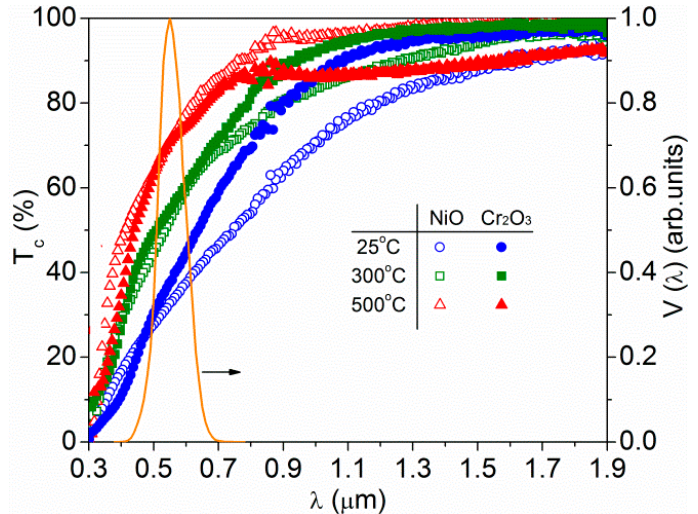
Figure 4. Optical transmittance spectra for the NiO and Cr 2 O 3 films as grown at room temperature and after heating in air at 300 °C or 500 °C. The standard photopic vision V( λ ), which describes the sensitivity of the human eye, is included for comparison.